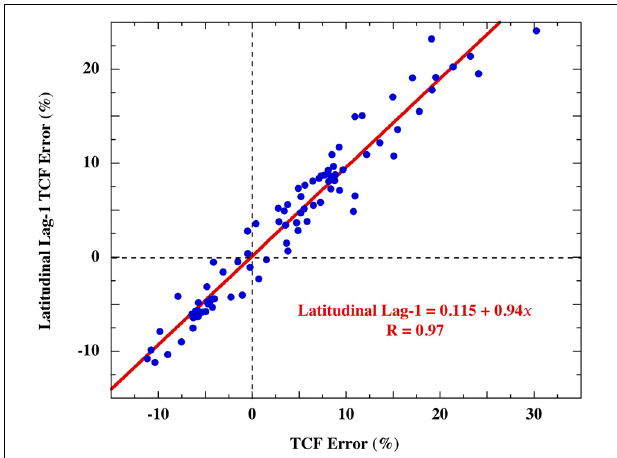
FIGURE 5 | Points: the lag-1 autocorrelation of the CSIRO_mk3.6 climate model average annual TCF hindcast (observed minus simulated) error residual that appeared in Figure 4 . The line is a linear least squares fit.